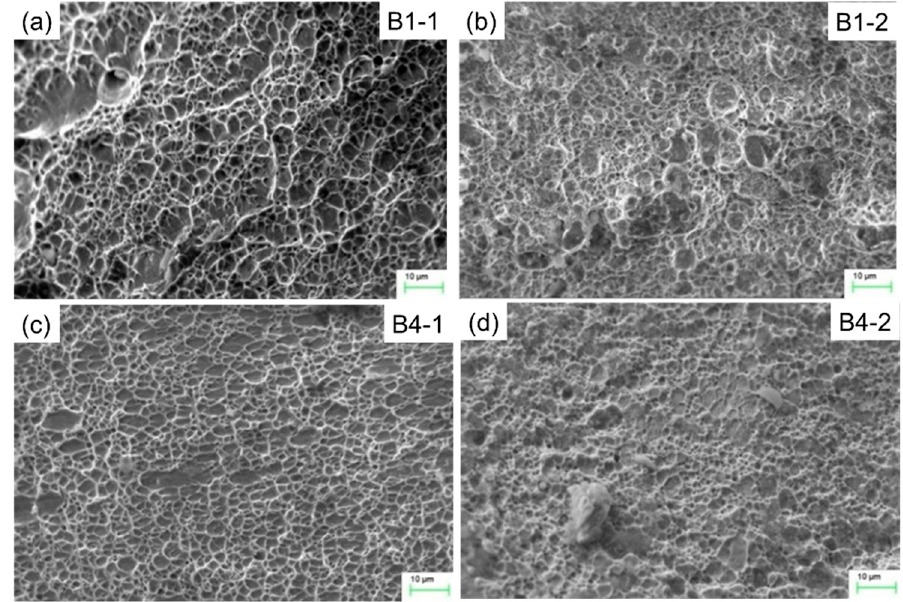
Figure 19. The micro-fracture surface morphologies in parent metal of the SSRT specimens: ( a ) B1-1, ( b ) B1-2, ( c ) B4-1 and ( d ) B4-2.